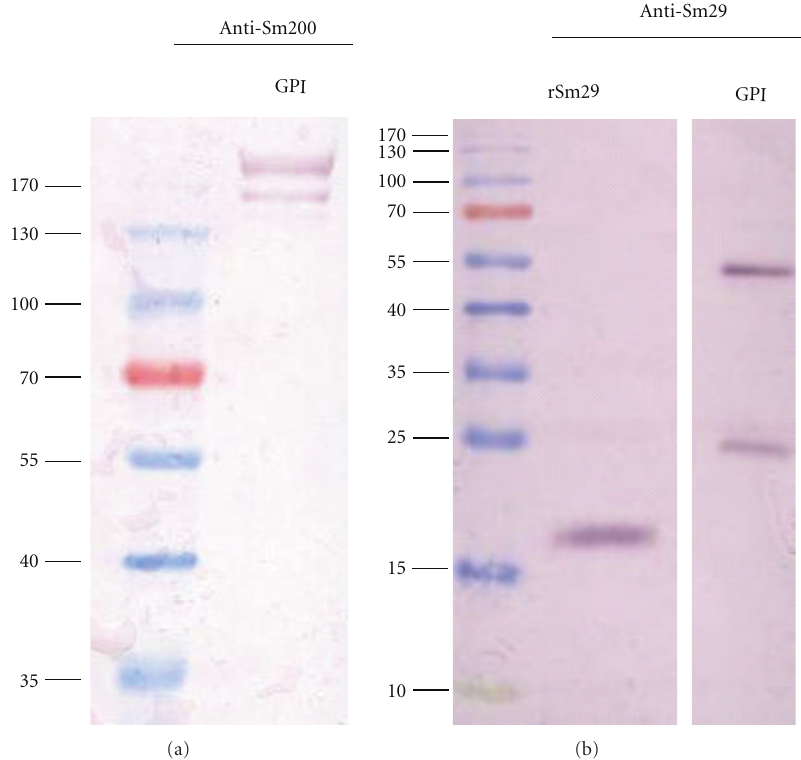
Figure 1: Analysis of GPI-anchored proteins purified from the outer surface of adult S. mansoni worms. (a) Western blot analysis of GPI- anchored protein preparation (GPI lane) probed with polyclonal mouse anti-Sm200 antibodies. (b) Western blot analysis of GPI-anchored proteins preparation (GPI lane) and recombinant Sm29 (rSm29 lane) probed with polyclonal mouse anti-Sm29 antibodies. The broad range pre-stained ladder from BioRad was used as molecular weight protein